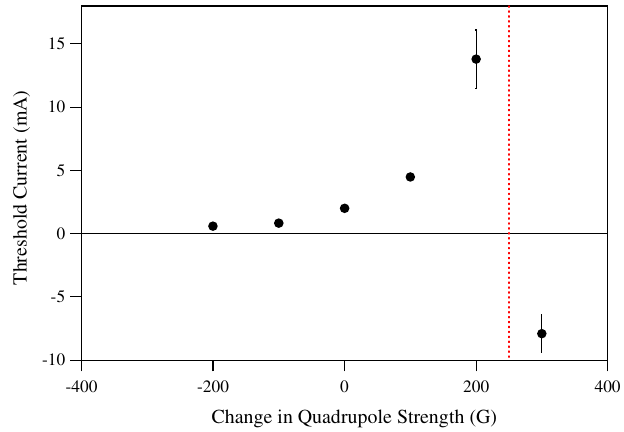
FIG. 11. (Color) A plot of the threshold current versus the change in quadrupole strength showing the effect of point-to- point focusing. At approximately 250 G the change in phase element of the recirculation matrix from advance makes the M 34 the cavity back to itself equal to zero before changing sign and hence the threshold current to be